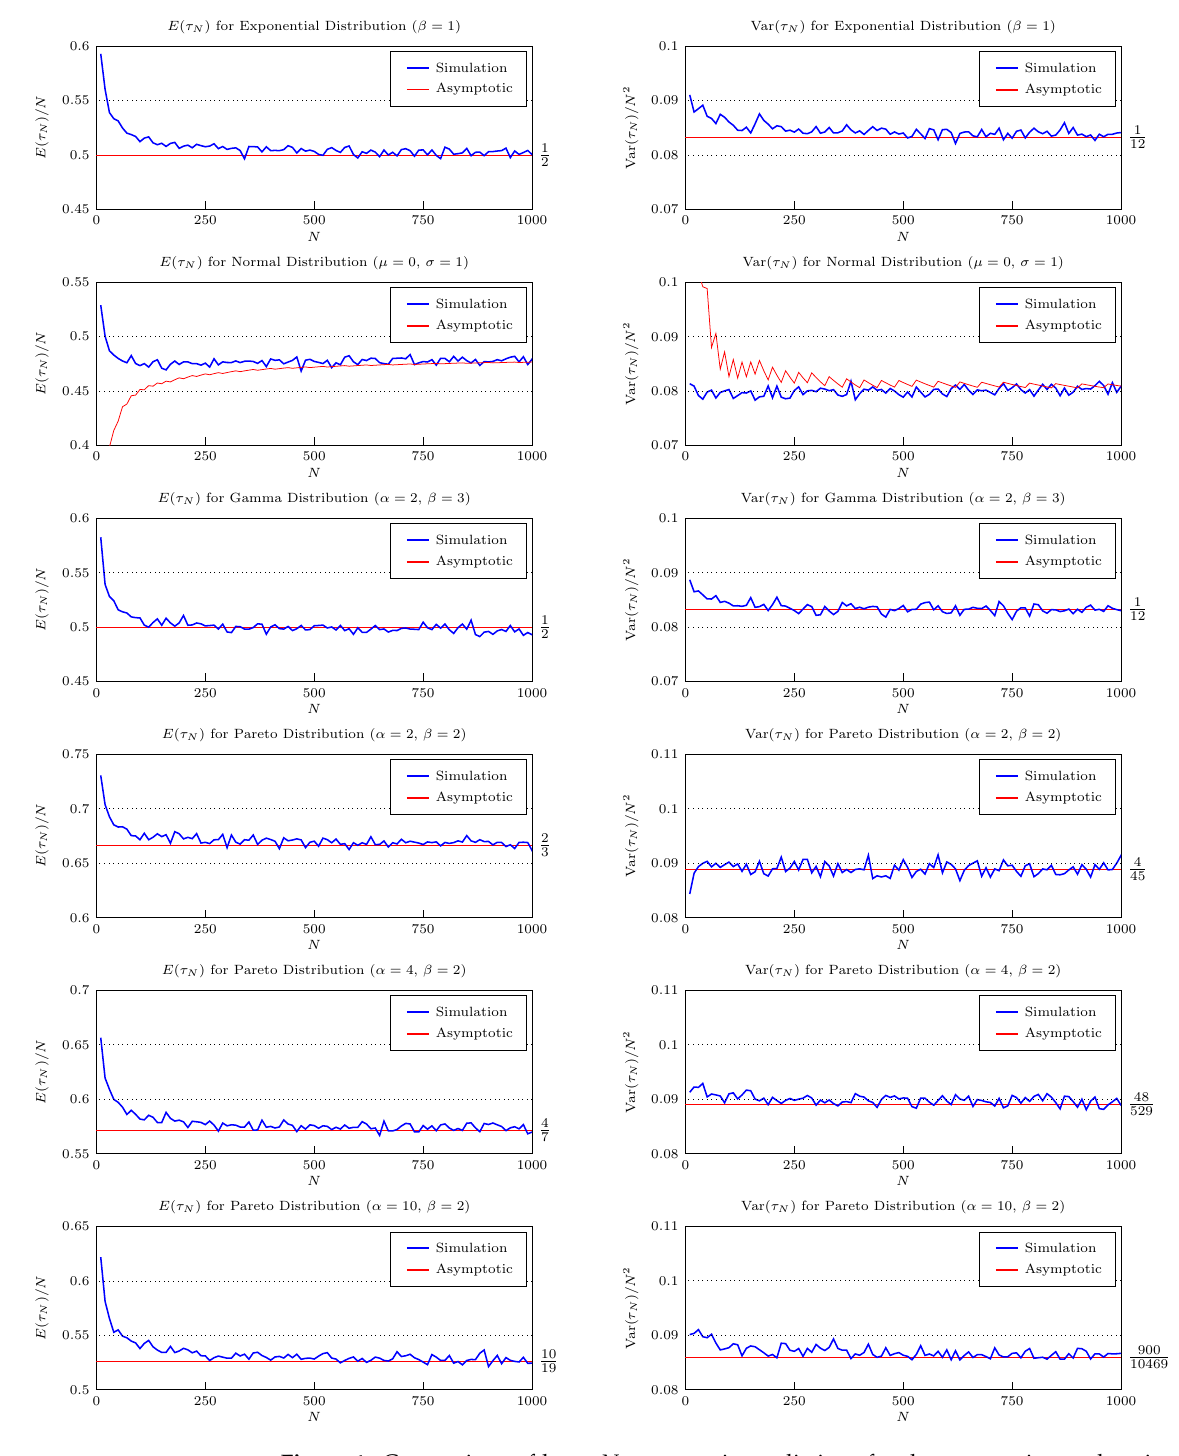
Figure 1. Comparison of large- N asymptotic predictions for the expectation and variance of the optimal stopping rule for a range of distributions on unbounded domains. The asymptotic prediction is shown in red, while the simulated result is shown in blue. Each point on the simulated curve was obtained by simulating the optimal stopping problem 10,000 times, with the results used to estimate the expectation and variance of the optimal stopping point. We note that, for convenience of presentation, the expectation and variance were scaled by N and N 2 , respectively, so that the curves tended to a constant value. The first correction term was retained in the asymptotic comparison for the normal distribution, as the asymptotic decay of this term was particularly slow in the large- N